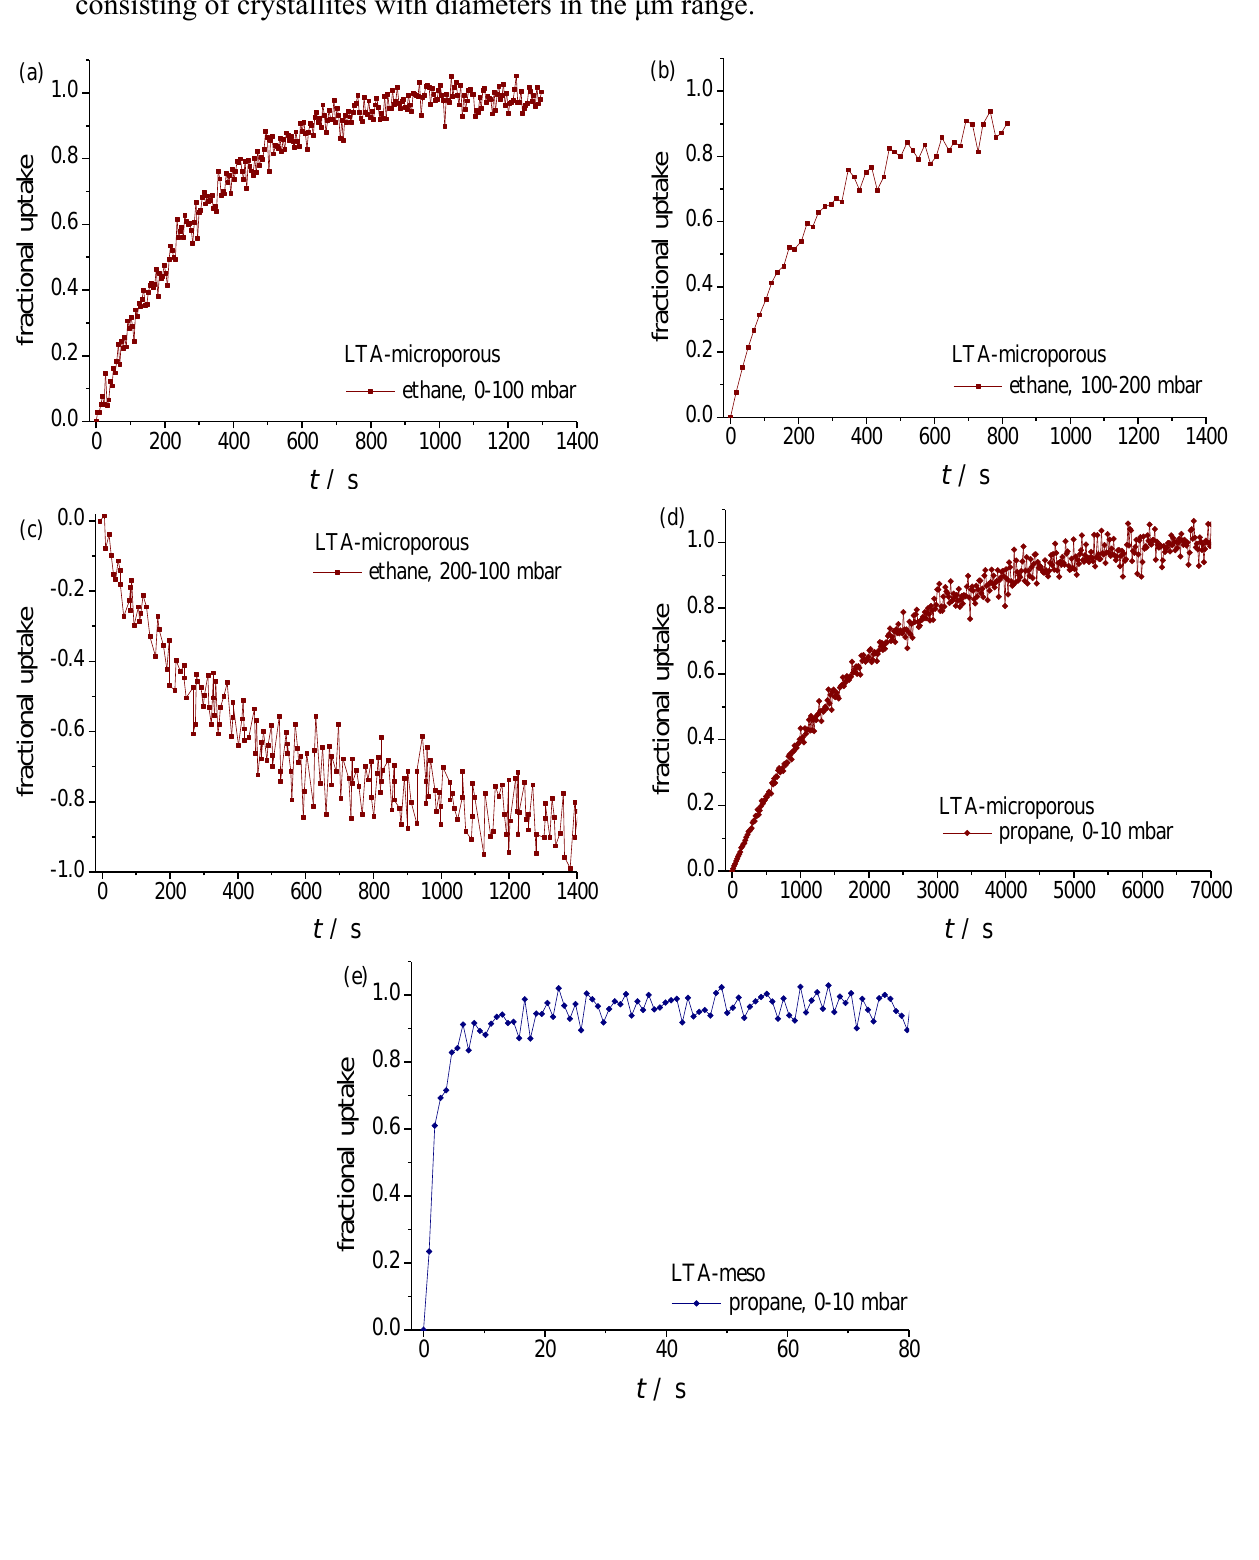
Figure 7. ( a , b , d ) Molecular uptake; ( c ) and release with ethane and propane at 298 K in the specimens of purely microporous zeolite LTA (NaCaA-LTA-0) under the conditions given in the insets; ( e ) and with propane in mesoporous LTA (NaCaA-LTA-2). For both samples, the selected particles were agglomerates with a radius of the order of 15μm, consisting of crystallites with diameters in the μm